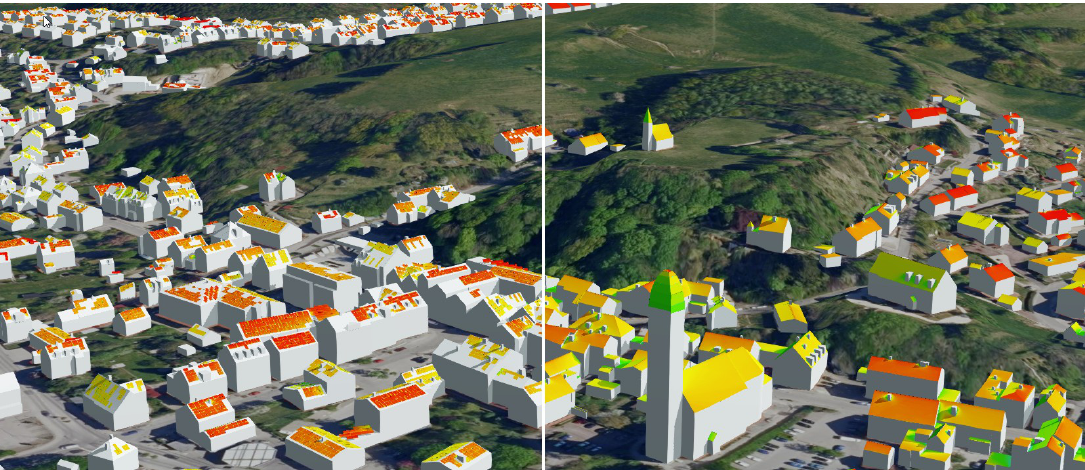
Figure 4. Study area in Wartenberg: On the left panels with RSS and on the right solar potential on complete roof segments are shown. which lacks slope information and shading effects, also